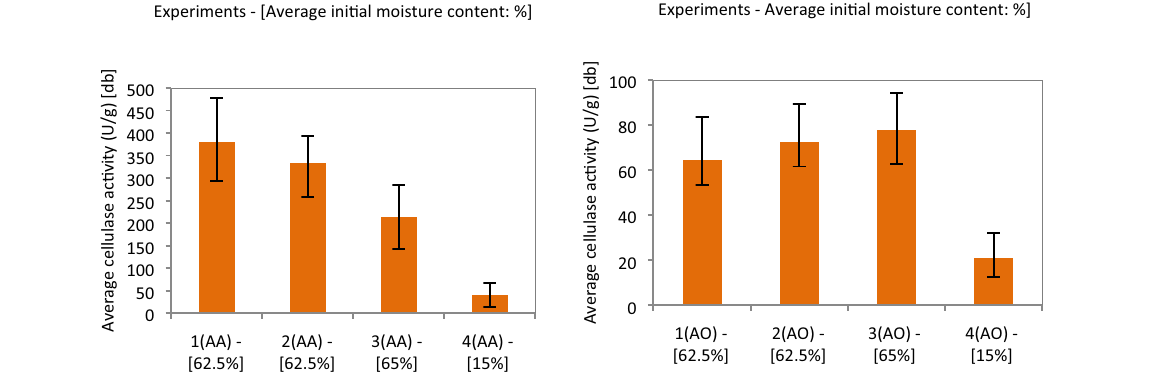
standard deviation, and number of replications is ±